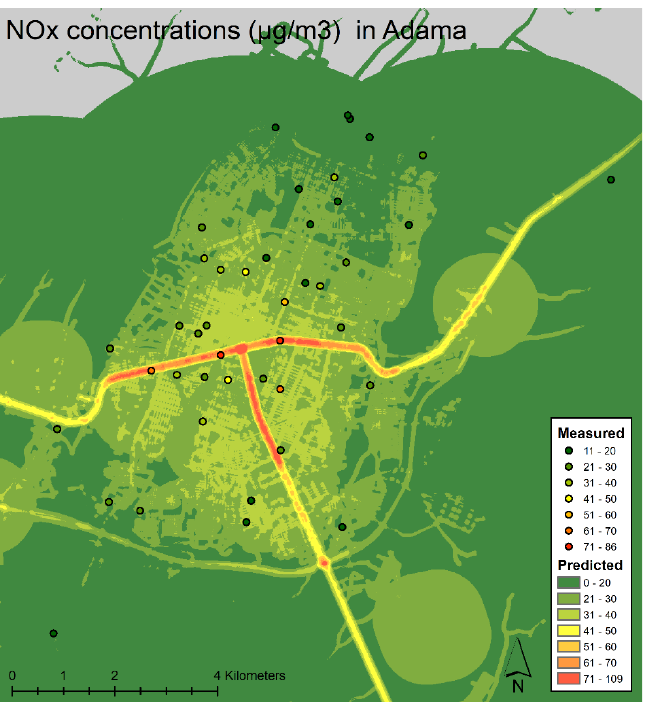
Figure 6. Prediction map of NO x concentrations in a 10-m grid over Adama based on the developed LUR model. Measured levels of NO x are presented by dots. Grey marks areas were the model predicted zero or below.